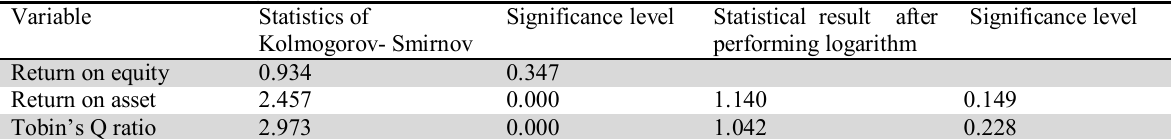
The results of Kolmogorov- Smirnov test Variable